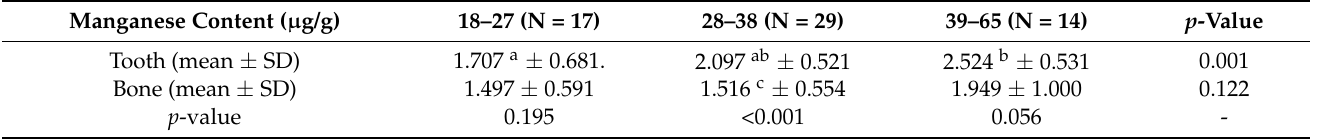
Table 26. Manganese content in tested samples taken from patients of different age. Manganese Content ( µ